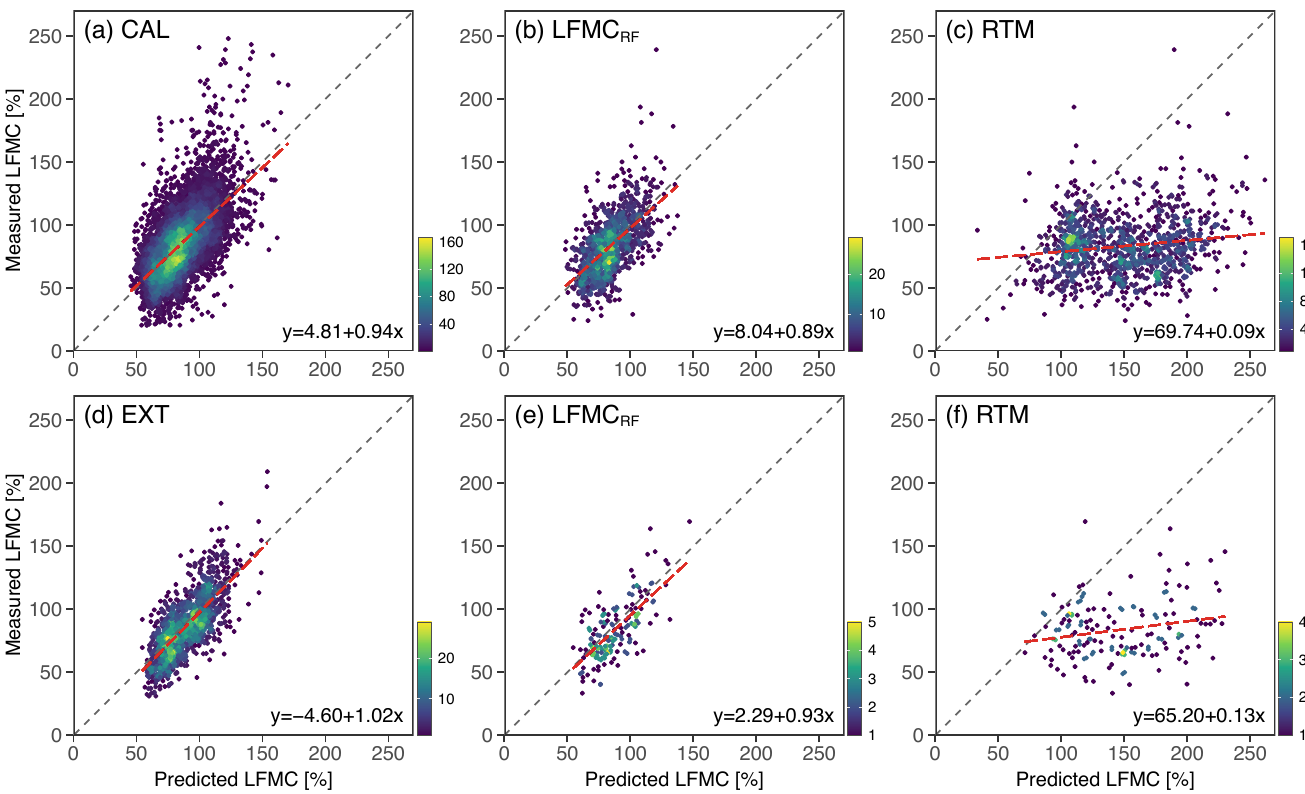
Figure 4. LFMC field measurements versus predictions from CAL (upper plots) and EXT (lower plots): all predictions ( a , d ), LFMC RF predictions made on the same data points available in RTM ( b , e ), and the corresponding RTM ( c , f ). Dashed black line and red line indicates the expected 1:1 relationship and the fitted linear model, respectively. Color scale indicates point